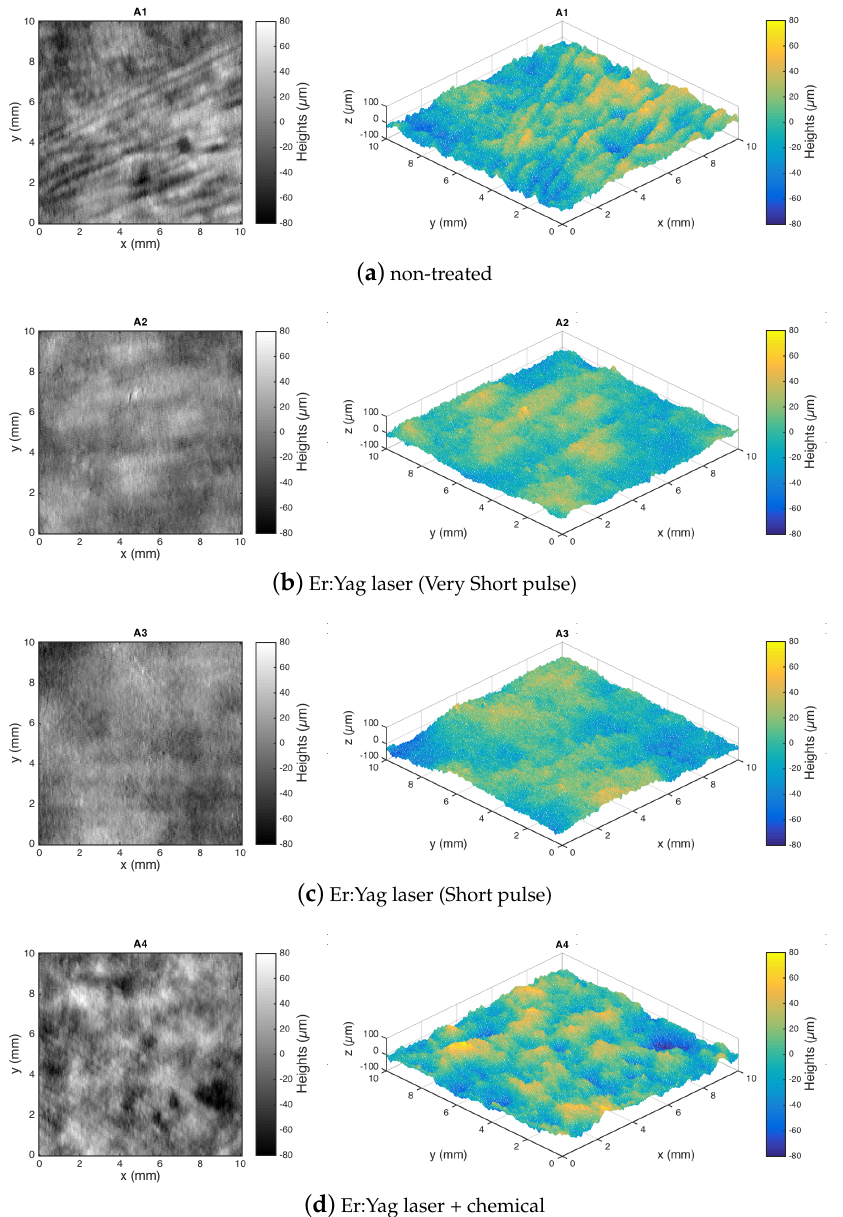
Figure 4. Experiment 1-dataset ( a ). Different red lake ROIs with different surface processing: surface data plotted as intensity maps and 3D